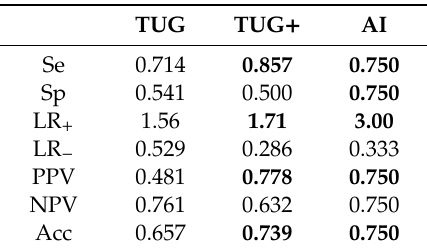
Figure 8. CNN-based AI algorithm used to predict the risk of fall. The input layer receives a 20 s frame from the 6 inputs of the DYSKIMOT sensor. The convolutional layers (Conv2D layer) extract meaningful features from its input and present it to the next stage. Pooling layers (MaxPool2D Layer) reduce the dimension of the feature space by retaining the meaningful inputs of its layer only. After several convolutional stages, the remaining features are injected in a three layers neural network